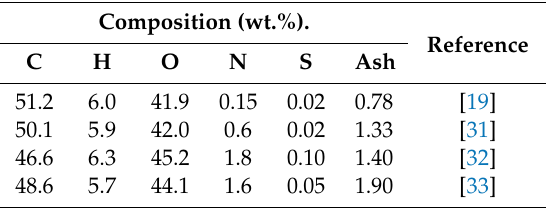
Table 4. Elemental analysis and ash content of olive stones.